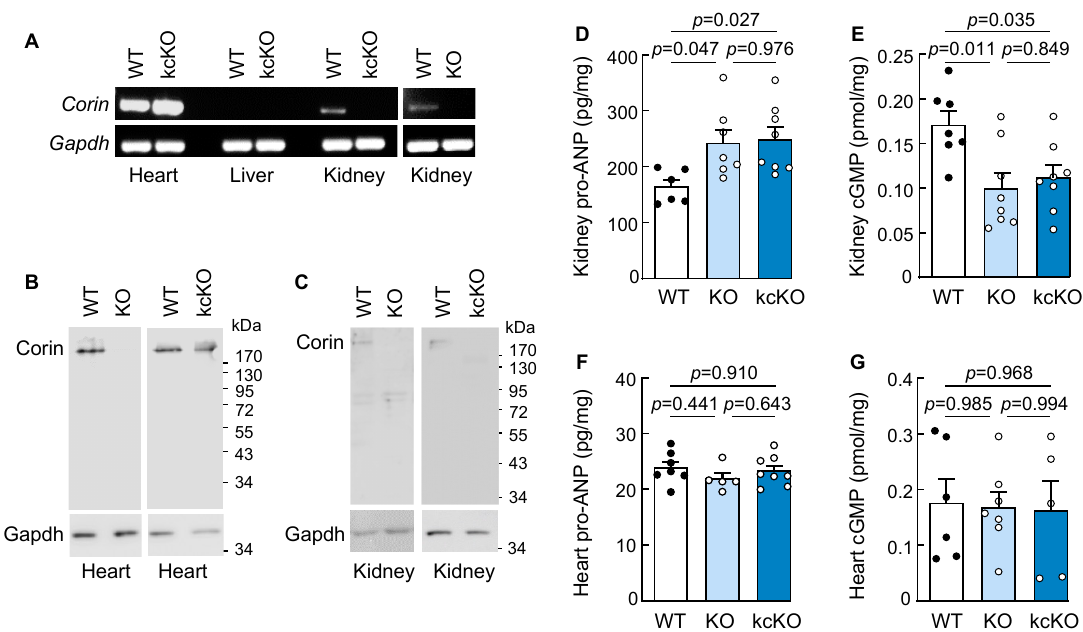
Figure 1. Analysis of corin kcKO mice. ( A ) RT-PCR analysis of Corin mRNA expression in the heart, liver (negative control), and kidney from WT, corin kcKO, and KO mice. Gapdh mRNA expression was used as a control. Data are representative of at least three experiments. ( B , C ) Western blotting of corin protein in the heart ( B ) and kidney ( C ) in WT, corin KO, and kcKO mice. Gapdh protein expression was the control. Data are representative of at least three experiments. ( D – G ) Levels of pro-ANP ( D , F ) and cGMP ( E , G ) in the kidney ( D , E ) and heart ( F , G ) homogenates from male WT (black dots), corin KO, and kcKO (white dots) mice were measured by ELISA ( n = 5–8 per group). Data shown are mean ± SEM. P -values were analyzed by one-way ANOVA.